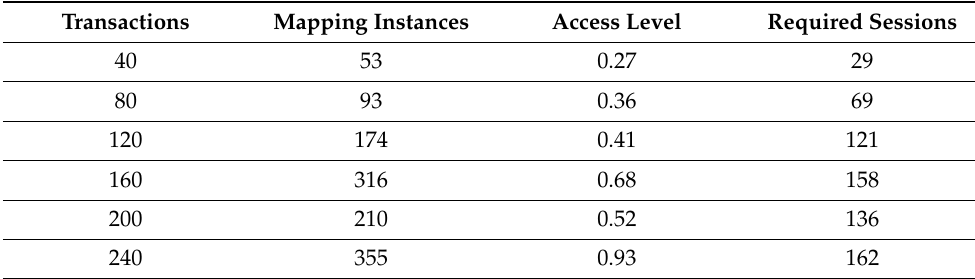
Table 2. Required sessions for transactions.